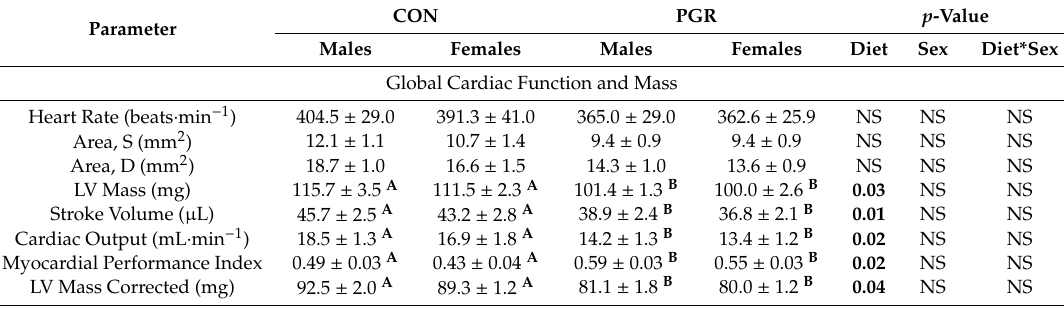
Table 2. Echocardiography between control (CON) and growth-restricted (PGR)